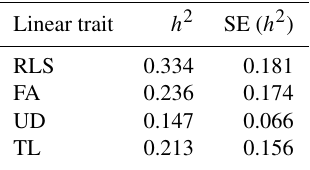
Table 5. Estimated heritabilities and the standard